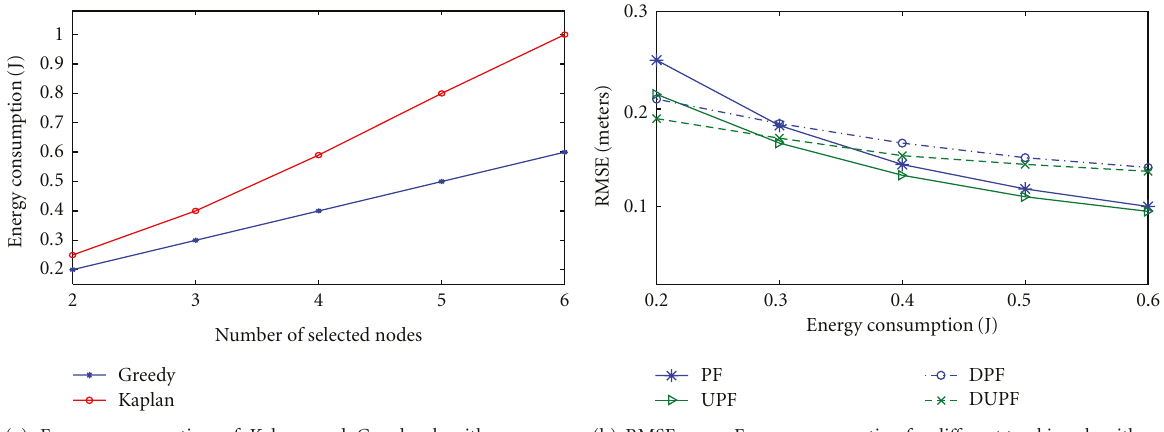
Figure 7: Energy consumption